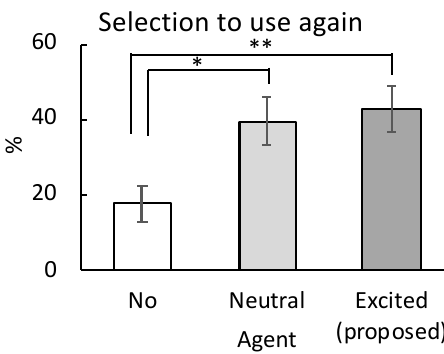
Figure 12. Participants’ mean re-selection percentages (with standard error bars) under each experimental condition. ** p < 0.01; * p <